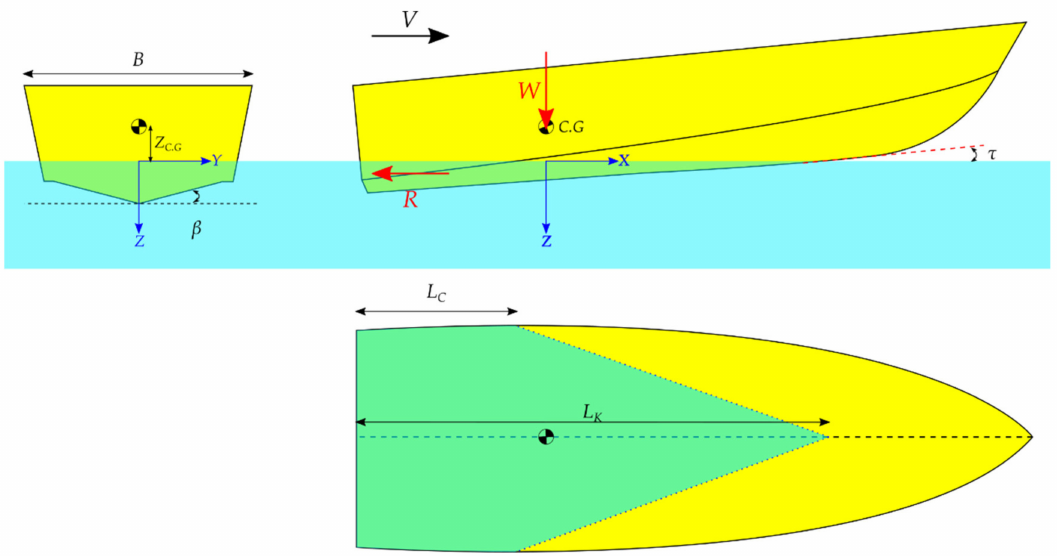
Figure 1. A deep-V boat operating at speed V in planing mode. Longitudinal and transverse views are shown in the upper panel and the bottom view of the vessel is shown in the lower